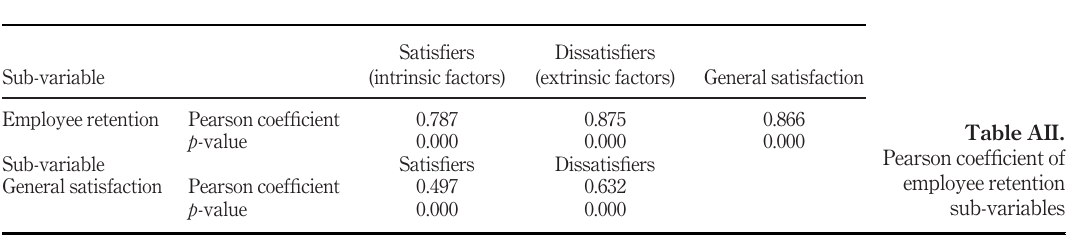
Table AI. Pearson coef fi cient of